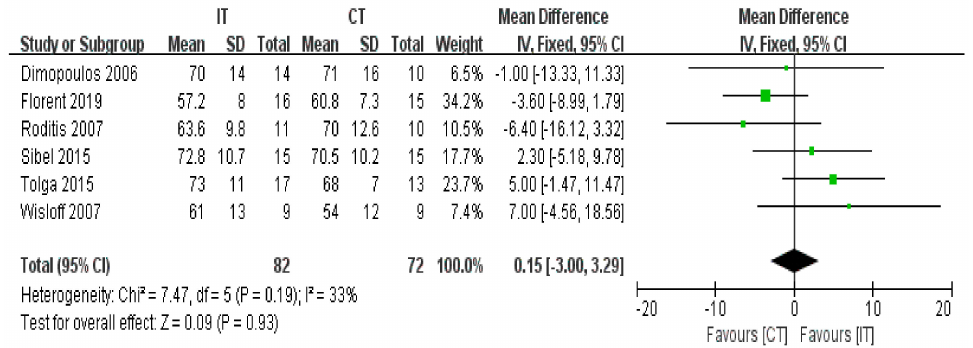
Figure 7. Forest plot: Effects of HRrest.